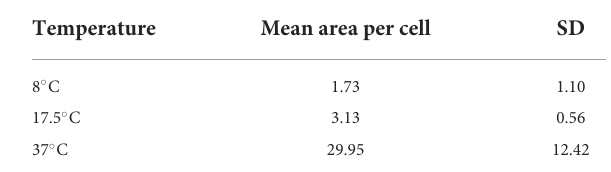
TABLE 5 Phagocyte activity (area of phagocyted zymosan particles per one cell) of macrophages cultivated at three different temperatures (8, 17.5, and 37 ◦ C; Experiment 4).